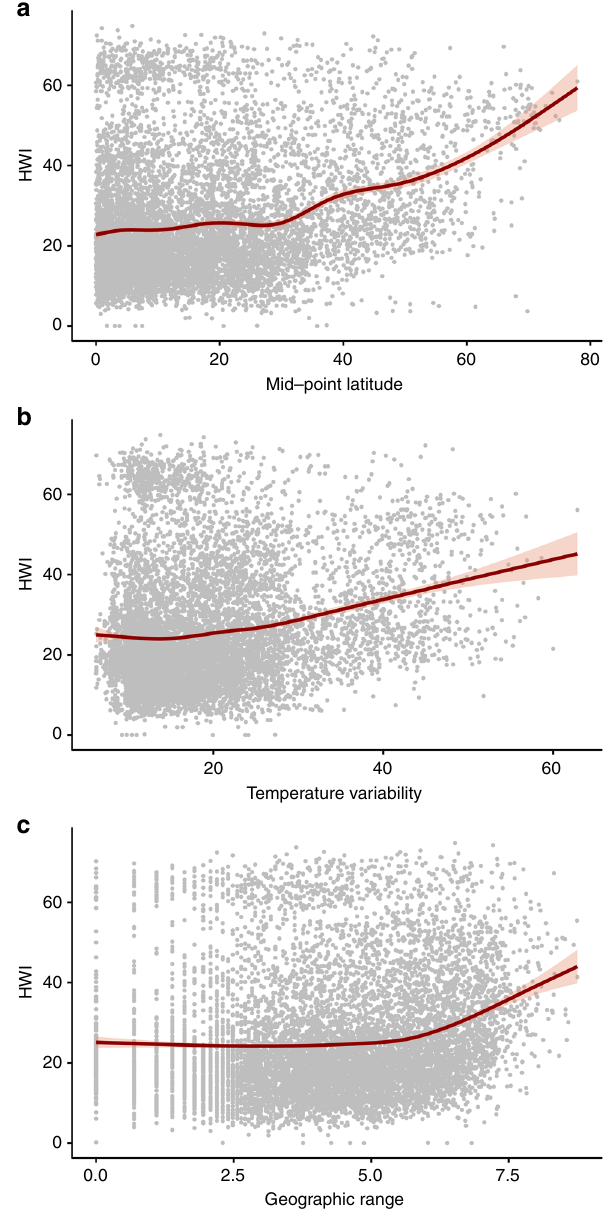
Fig. 5 Relationship between hand-wing index (HWI) and environmental variables. Panels show how HWI of all birds ( n = 9353 species) varies with ( a ) latitude, ( b ) temperature variability, and ( c ) geographical range size. All environmental variables are generated from polygons of breeding ranges; climatic variables are calculated for each grid cell of the range and averaged; overall range sizes (km 2 ) are log-transformed. Red line shows model fi t and pink shading shows 95% con fi dence